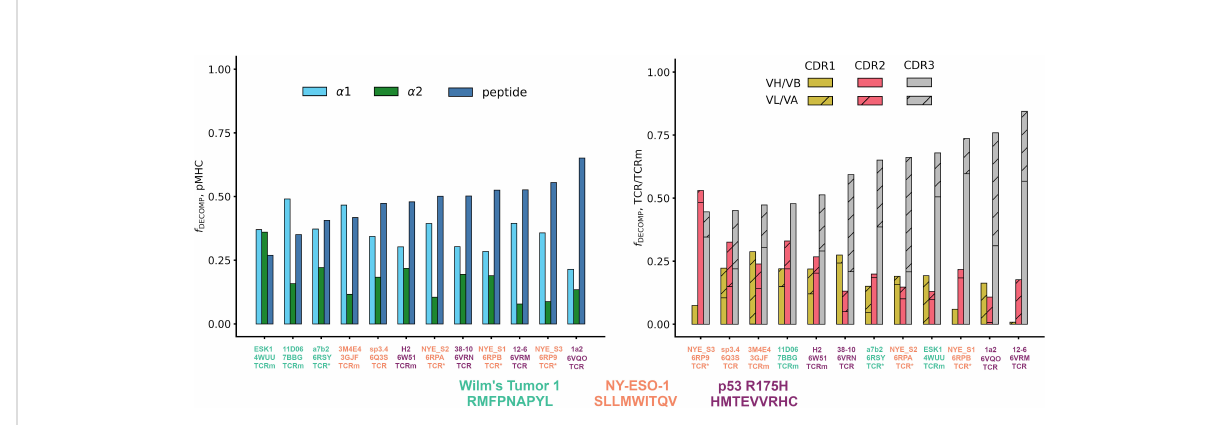
FIGURE 3 The energetics of pMHC binding of TCR-mimetic antibodies (TCRms), natural T-cell receptors (TCRs) and af fi nity-enhanced T-cell Receptors (TCR*s). (LHS) Relative contributions of the peptide, the MHC a 1 helix, and the MHC a 2 helix to the MMGBSA free energy change (42). Individual values were computed with Supplementary Equations 1-3, and then rank ordered by increasing peptide contribution. (RHS) Relative contributions to binding free energy of the CDR1, CDR2, and CDR3 loops for the heavy/beta chain (no hatch) and light/alpha chain (diagonal hatch), calculated as described in Methods. Complexes were rank ordered by increasing CDR3 contribution. Note that the CDR1, CDR2, and CDR3 bars do not sum to exactly one for all complexes as small negative values of the fraction of the DECOMP energy ( f DECOMP ), representing CDRs that experience repulsive interactions with the pMHC, were passed to zero for visual clarity. NY-ESO-1: New York esophageal squamous cell carcinoma